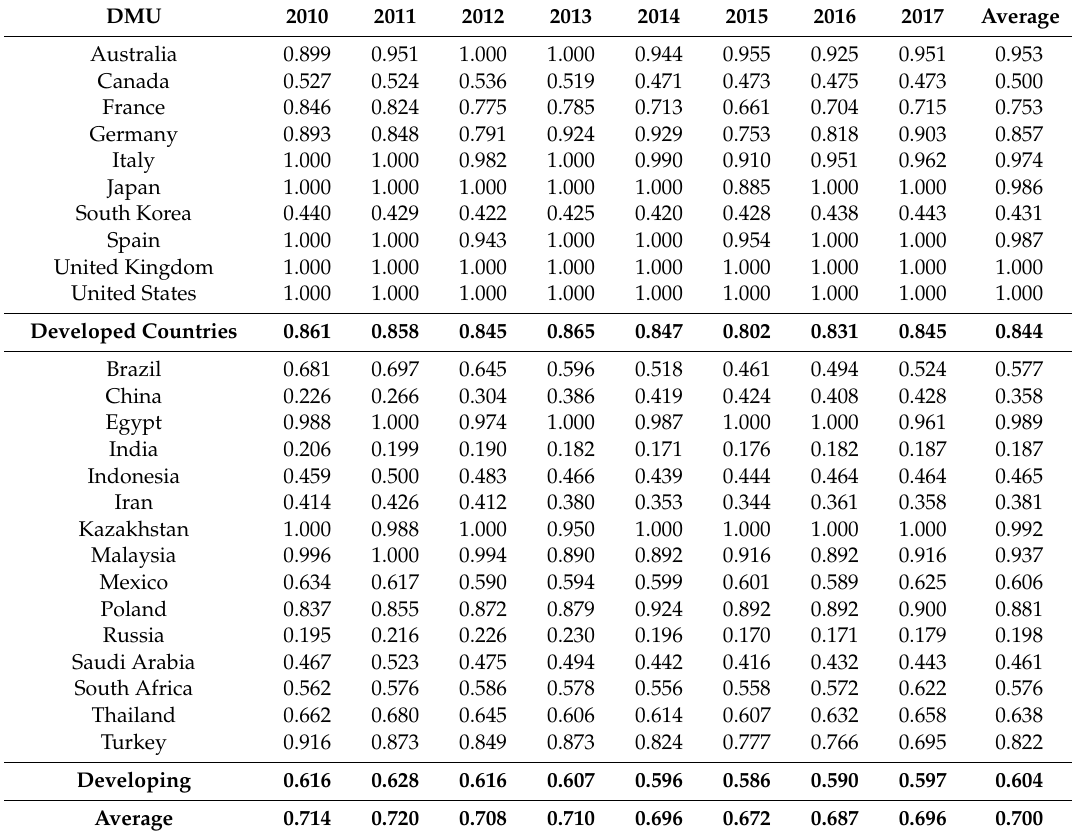
Table 3. Particular-factor energy e ffi ciency during